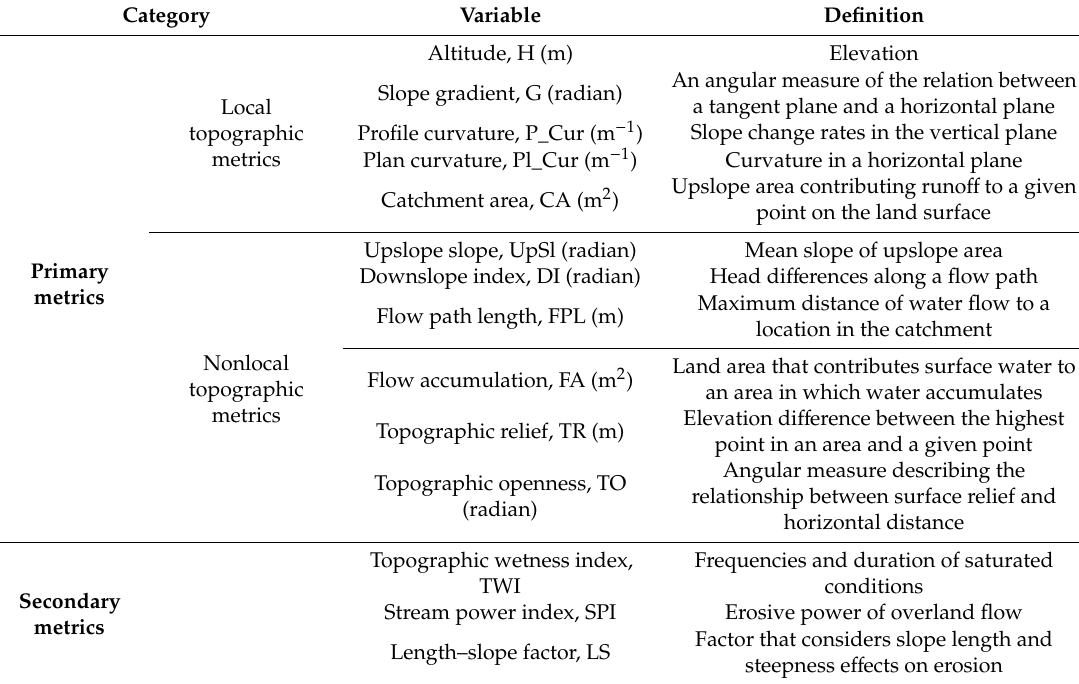
Table 1. Definitions of selected topographic